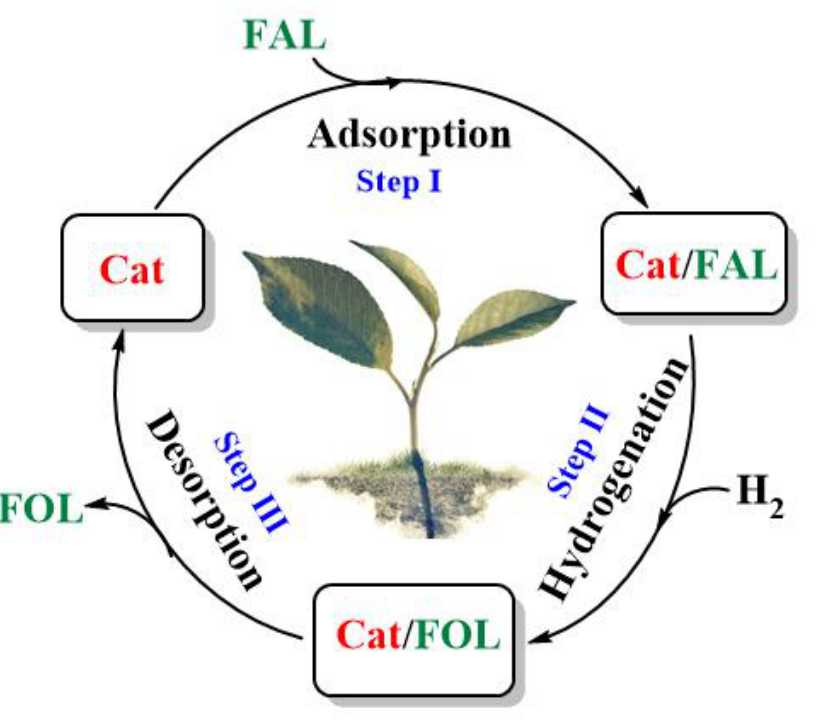
Scheme 1. Reaction pathway of the catalytic conversion from furfural to furfuryl alcohol.